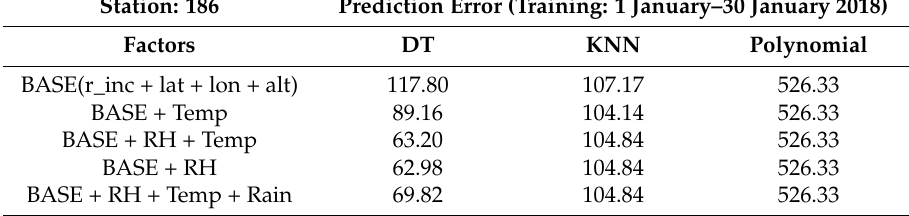
Table 13. Task 4: missing data prediction error of the sensor attribute r_inc from both monitoring station 173 and 186 using decision trees (DT), KNN, and polynomial machine learning methods on IoT Sensors dataset.